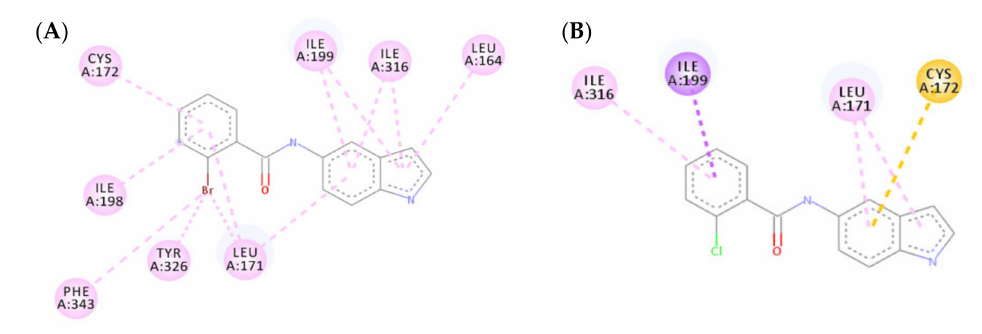
Figure 5. Two-dimensional (2D) interaction models of compounds 3b ( A ) and 3o ( B ) with MAO-B.